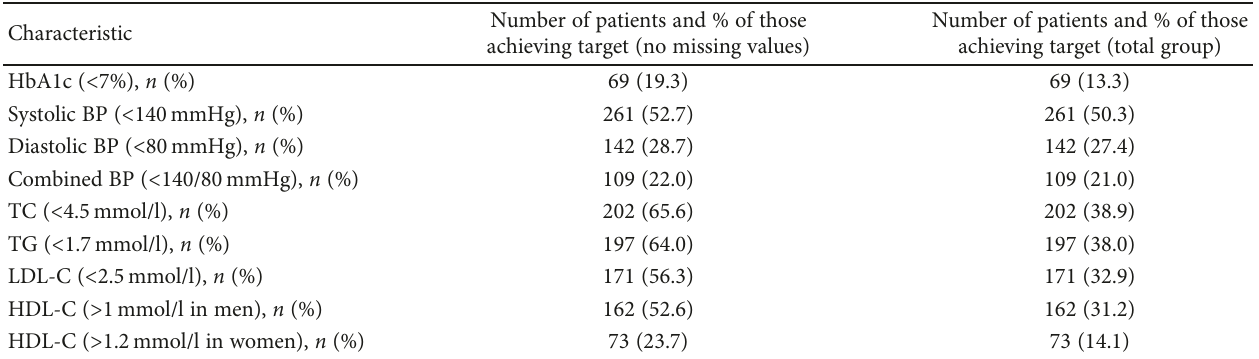
Table 2: Intermediate outcomes: patients with T2DM attending the Hillbrow Community Health Centre. Number of patients and % of those Characteristic achieving target (no missing values)